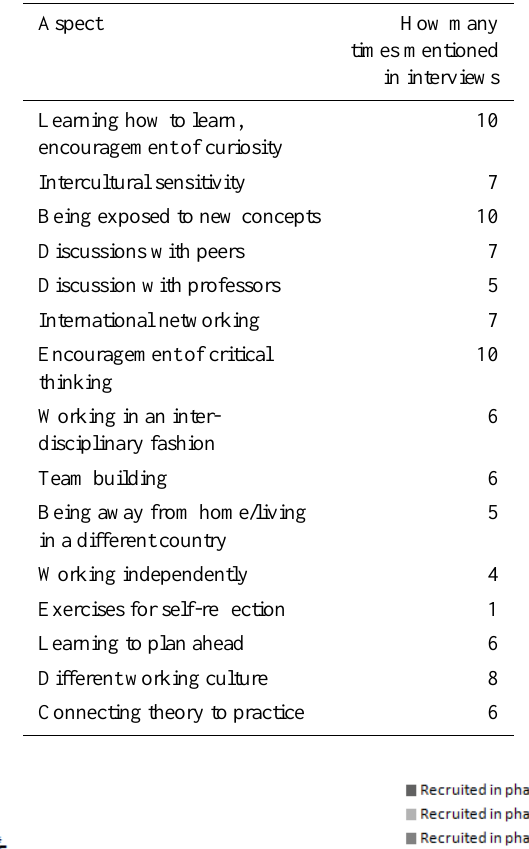
Table 4. Most important aspects of international post-graduate ed- ucation, as perceived by interview respondents.